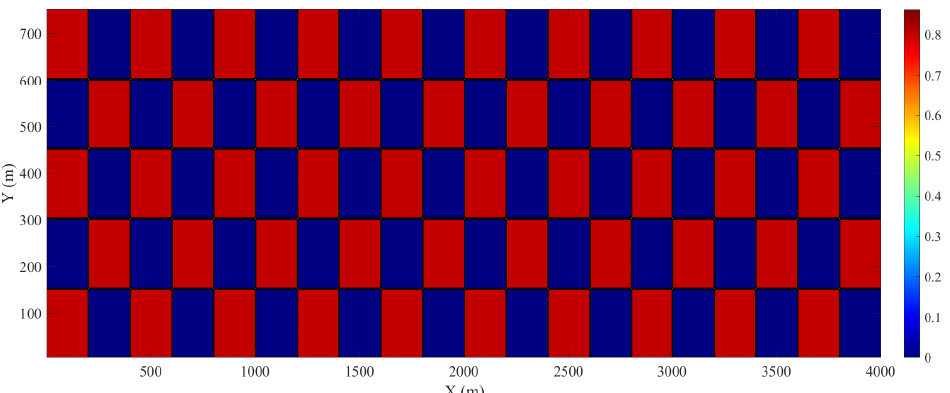
Figure 5. Two-dimensional (2D) LAI map for patched forest (idealized strong-heterogeneous forest) with mean LAI =